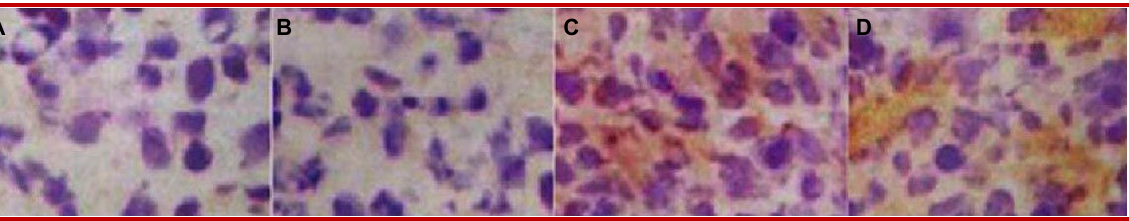
Figure 2: Immunohistochemical detection of tumor tissues. (A) control group; (B) low-dose group; (C) medium-dose group; (D) high-dose